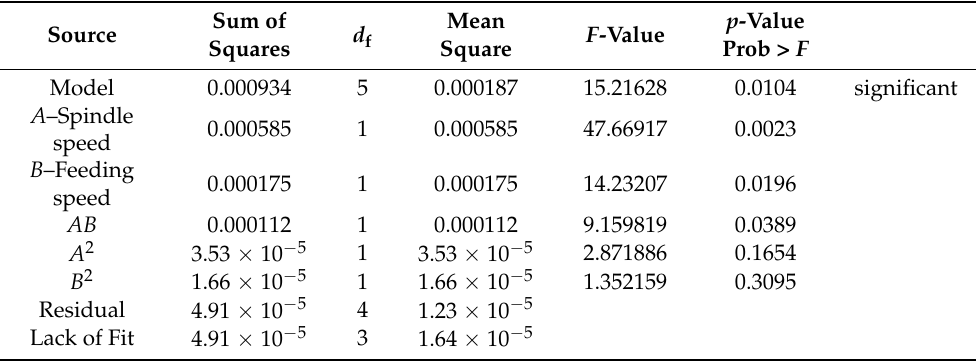
Table 4. Significance analysis of delamination